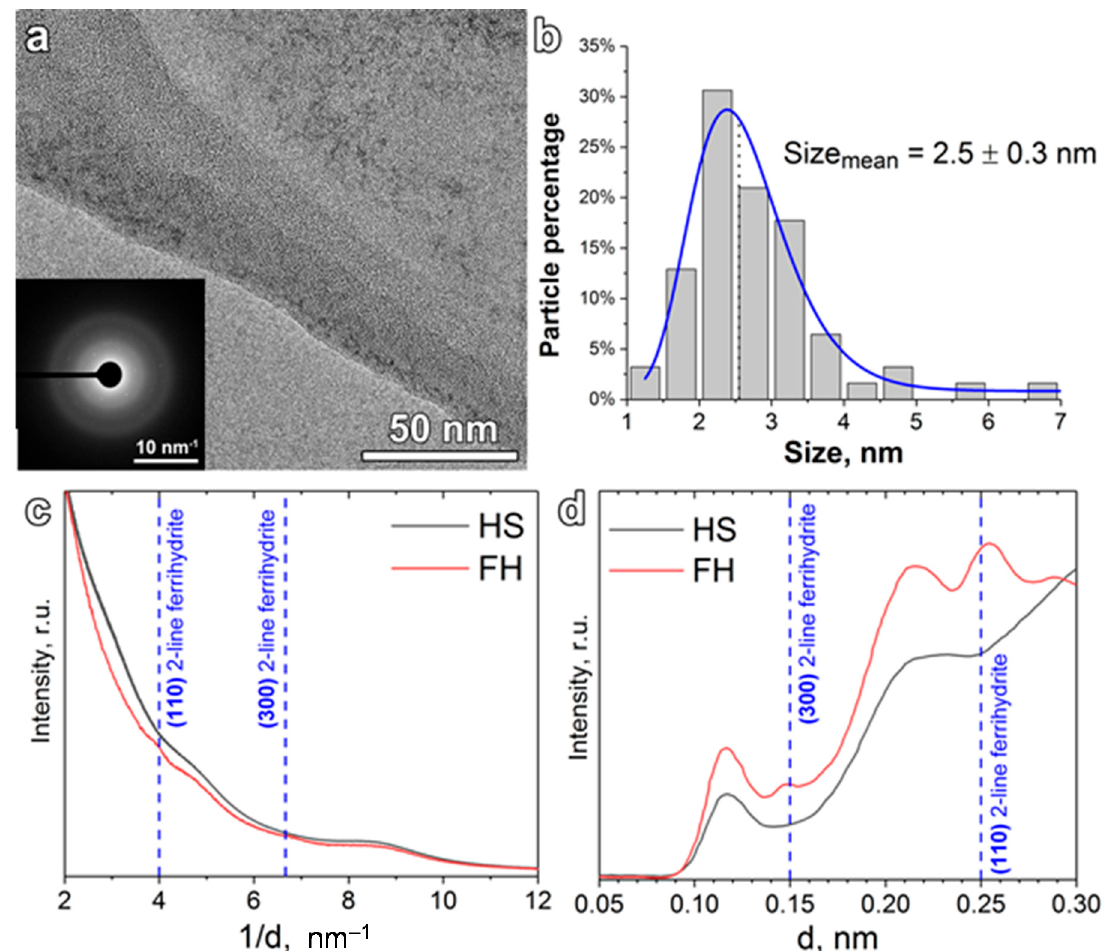
Figure 1. ( a ) TEM image of the synthesized ferrihydrite (FH) nanoparticles and the corresponding electron diffraction image (inset); ( b ) size distribution of nanoparticles in FH nanoparticles as revealed by TEM (log-normal fitting was used); ( c ) normalized electron diffraction integrals for the FH nanofertilizer and raw potassium humate (HS) (d is an interplane lattice spacing); ( d ) normalized background-subtracted electron diffraction of FH nanoparticles and raw potassium humate, replotted in d-space. Positions of the 2-line ferrihydrite reflections and lattice indexes assignments are given according to [60].